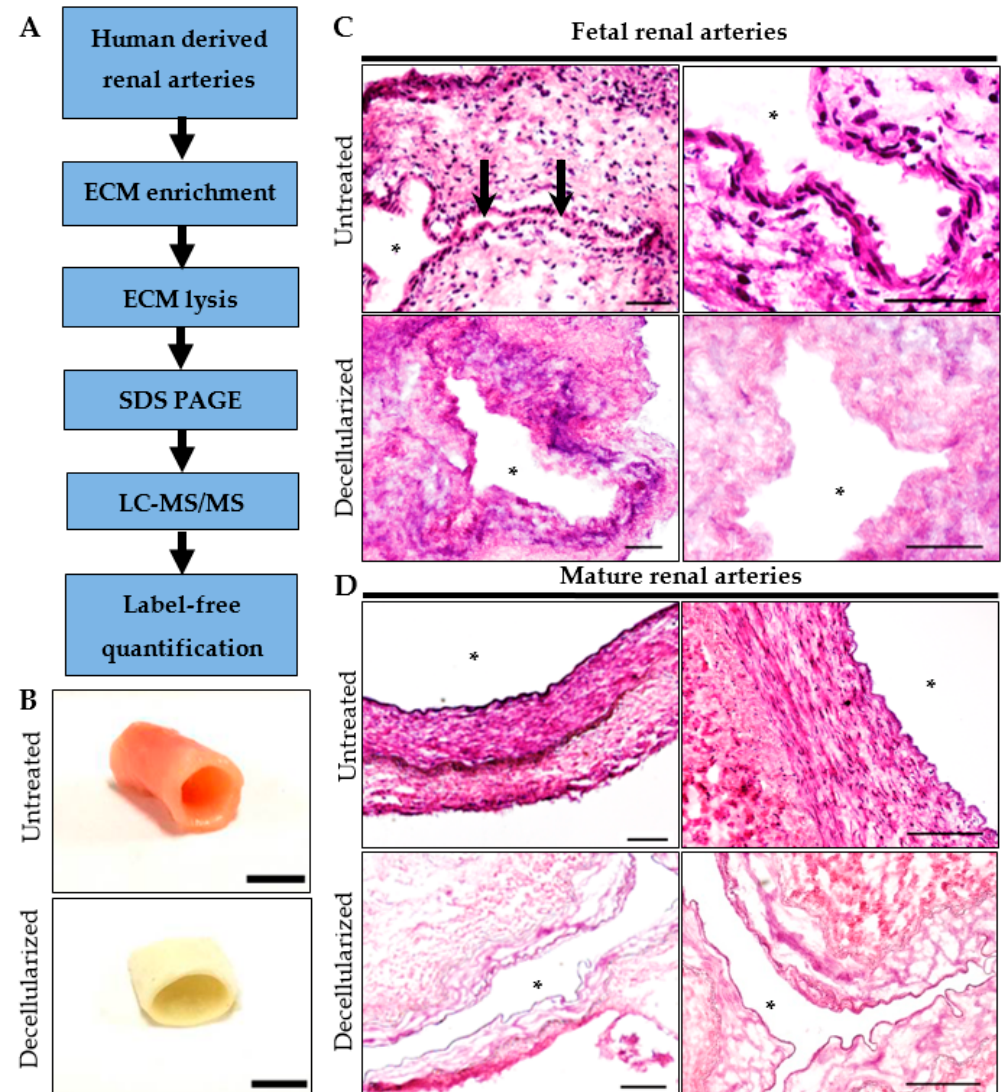
Figure 1. Proteomic workflow for extracellular matrix (ECM)-enriched vascular samples. ( A ) After decellularization of the human tissue, ECM-enriched samples were lysed and separated with SDS-PAGE prior to LC-MS / MS with label-free quantification. ( B ) Mature human renal arteries, before and after decellularization. Scale bar represents 1 cm. Hematoxylin and eosin staining for validation of decellularization procedure in ( C ) fetal human renal artery and ( D ) mature human renal artery. Black arrows indicate lumen. Open lumen is indicated with an asterix. Representative of 3 experiments. Scale bar represents 200 µm.